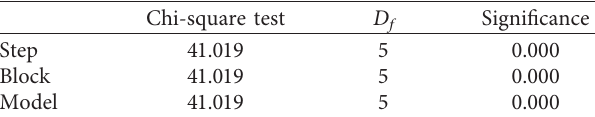
Table 2: Global test results of model coefficients.